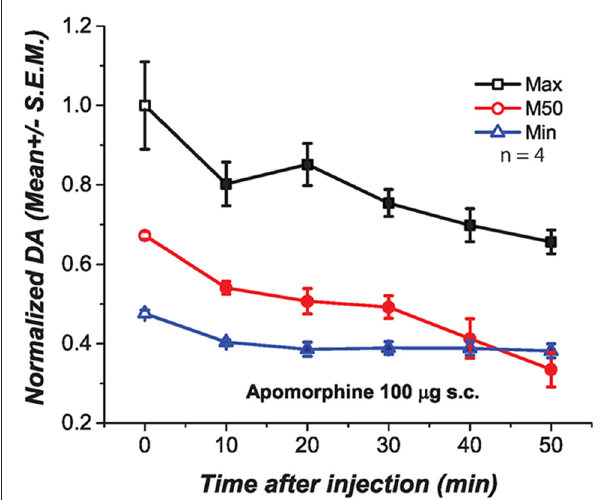
FIGURE 6 | Subcutaneous injection of apomorphine (100 µ g) produced a significant and long lasting reduction of DA oxidation at the three frequencies tested. Filled symbols represent a significant reduction of DA oxidation when contrasted against the pre-injection values, time 0.